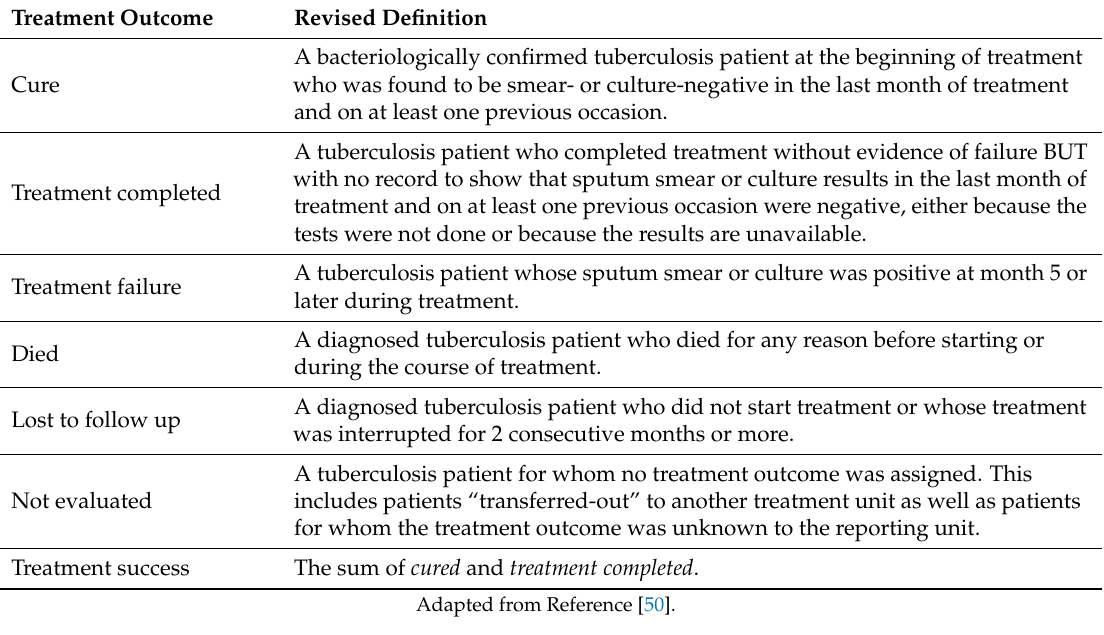
Table 4. Revised definitions of treatment outcomes for patients with drug susceptible tuberculosis: 2013 WHO